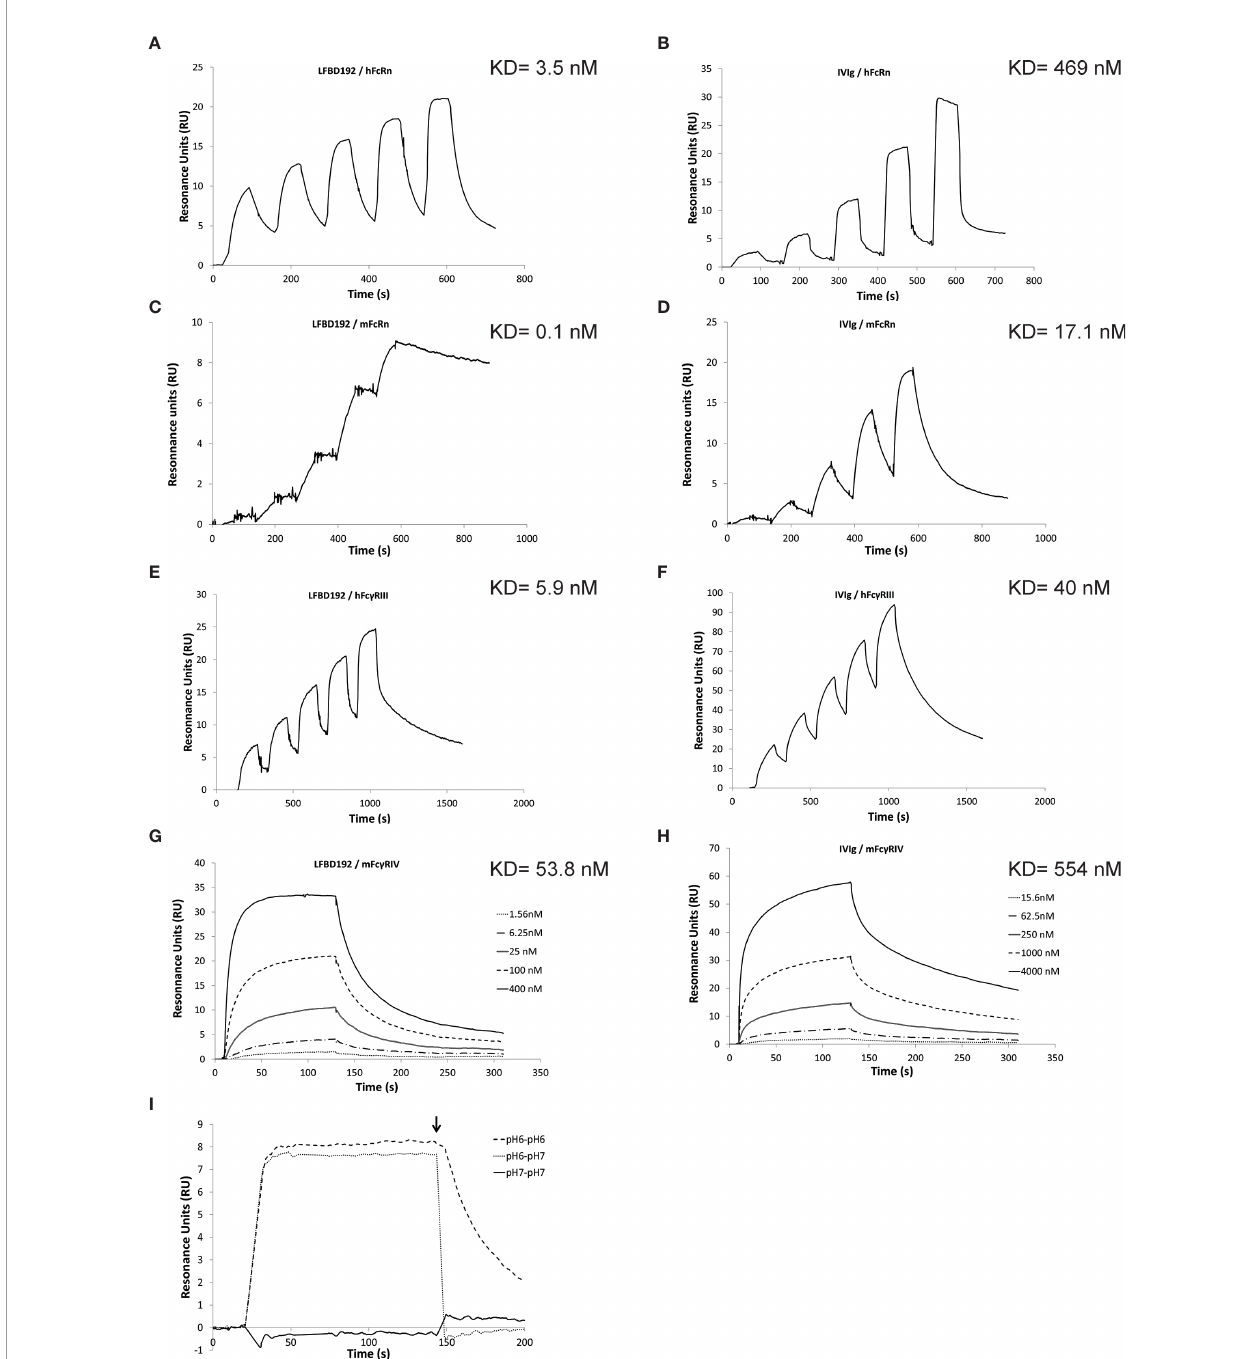
FIGURE 1 | Biacore analysis of LFBD192 binding to hFcRn and hFc g RIIIa. Representative surface plasmon resonance (SPR) sensorgrams obtained for (A) the injection of LFBD192 at 4.7 – 75 nM on ~25 resonance units (RUs) of immobilized hFcRn using phosphate at pH 6.0; (B) the injection of IVIg at 24.7 – 2,000 nM on ~25 RUs of immobilized hFcRn using phosphate at pH 6.0; (C) The injection of LFBD192 at 0.2 – 20 nM on ~50 RUs of immobilized mFcRn using phosphate buffer at pH 6.0; (D) The injection of IVIg at 3.7 – 300 nM on ~50 RUs of immobilized mFcRn using phosphate buffer at pH 6.0. (E) The injection of LFBD192 at 6.25 – 100 nM on ~40 RUs of immobilized hFc g RIIIa using Tris buffer at pH 7.4; (F) the injection of IVIg at 31.25 – 500 nM on ~80 RUs of immobilized hFc g RIIIa using Tris buffer at pH 7.4; (G) The injection of LFBD192 at 1.56 – 400 nM on ~40 RUs of immobilized mFc g RIV using Tris buffer at pH 7.4; (H) the injection of IVIg at 15.6 – 4,000 nM on ~40 RUs of immobilized mFc g RIV using Tris buffer at pH 7.4; (I) 100 nM injections of LFBD192 on 14 RUs of immobilized hFcRn in phosphate buffer pH 7.4 followed by a dissociation phase at pH 7.4 (solid line), phosphate buffer pH 6.0 followed by a dissociation phase at pH 6.0 (dotted line), or phosphate buffer pH 6.0 followed by a dissociation phase at pH 7.4 (dashed line) using dual injection mode. The end of the association phase is indicated by an